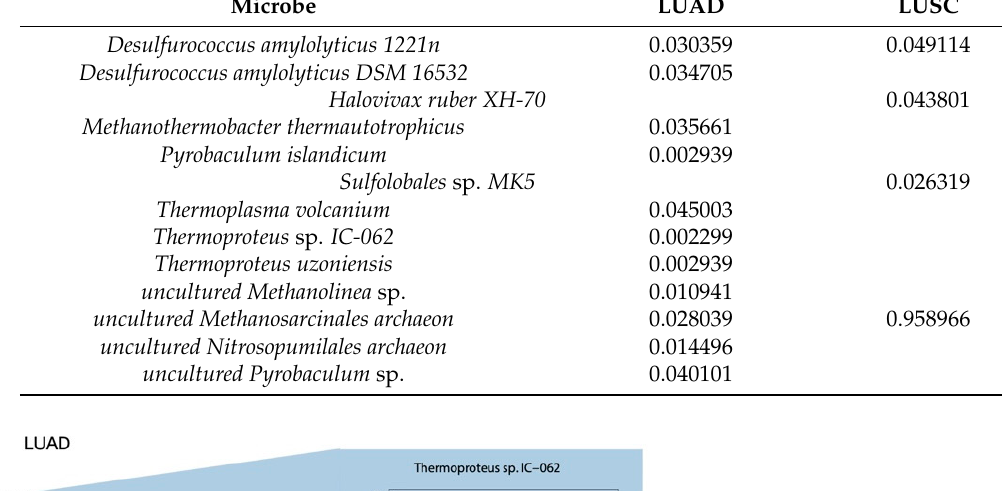
Table 3. List of survival-significant microbes across LUAD and LUSC samples. Corresponding p -Value denoting significance of relationship.